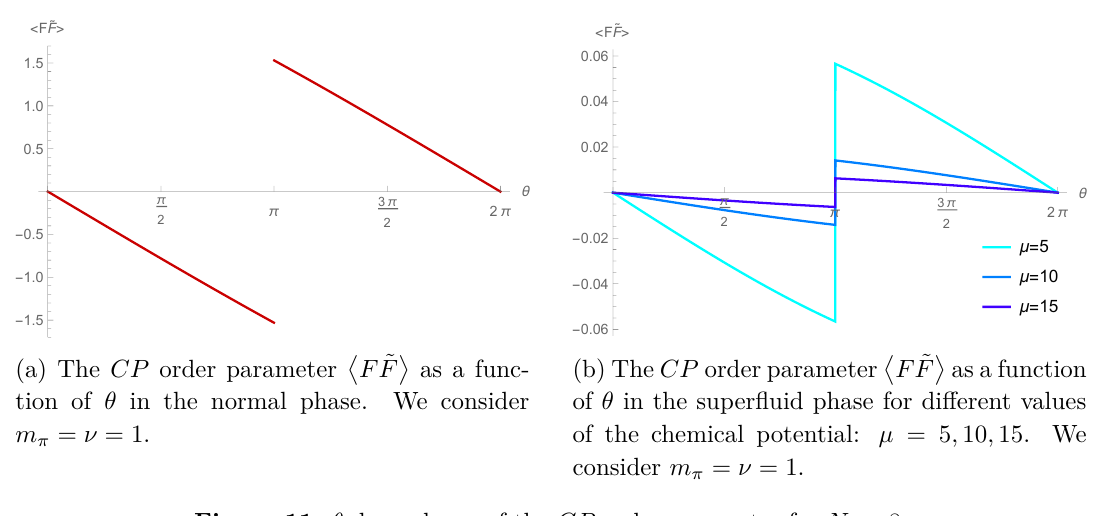
(a) The CP order parameter (cid:10) F ˜ F (cid:11) as a func- tion of θ in the normal phase. Figure 11 . θ -dependence of the CP order parameter for N f = 8